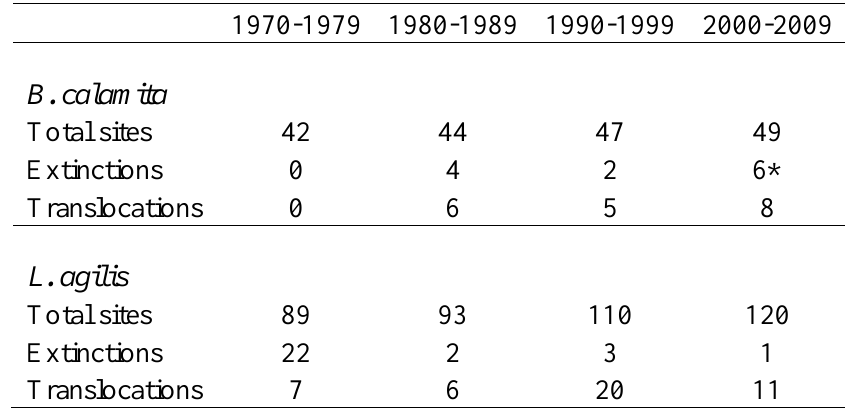
Table 6. Changes of status in Britain of B. calamita and L. agilis. Local extinctions and translocations are the number in each decade.